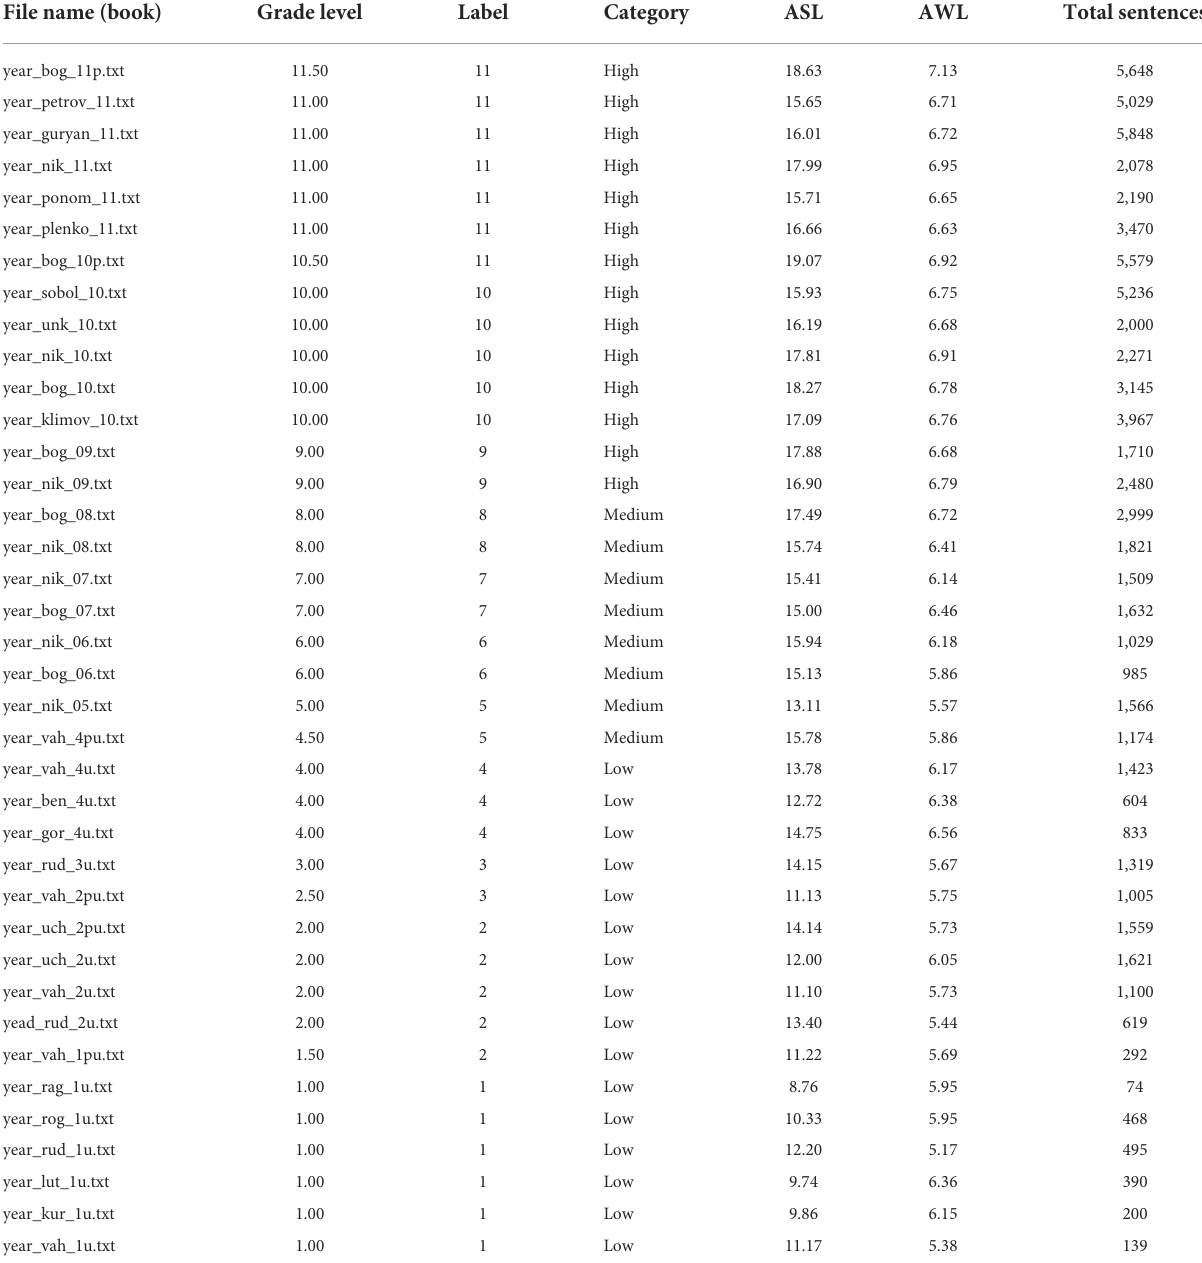
TABLE 1 Statistics on sentence length (ASL) and word length (AWL) of the initial textbooks